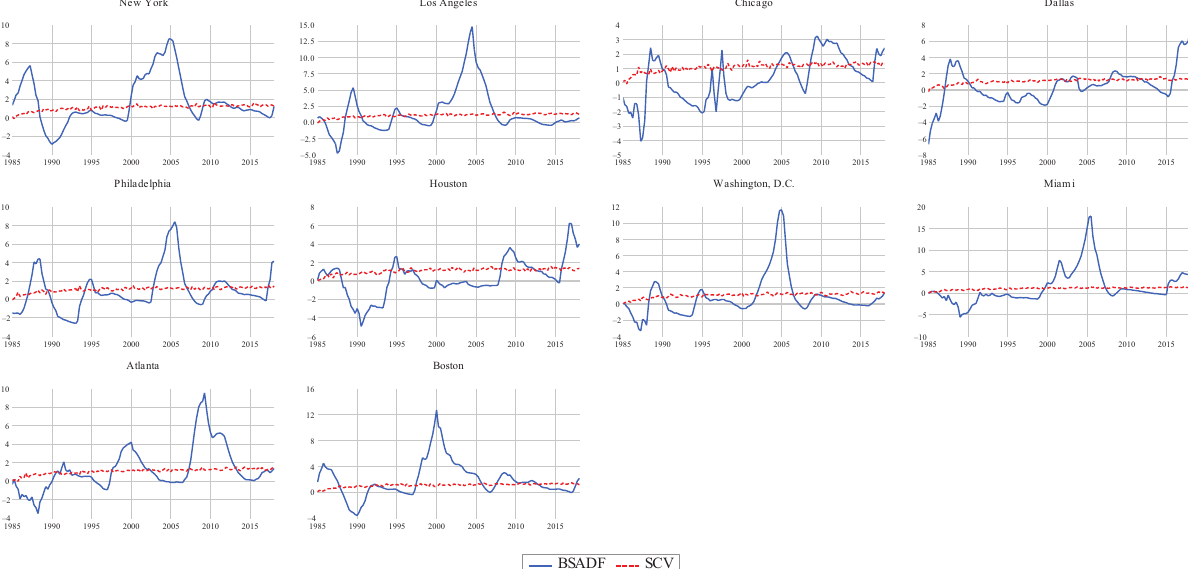
Figure 4. The statistics of the BSADF